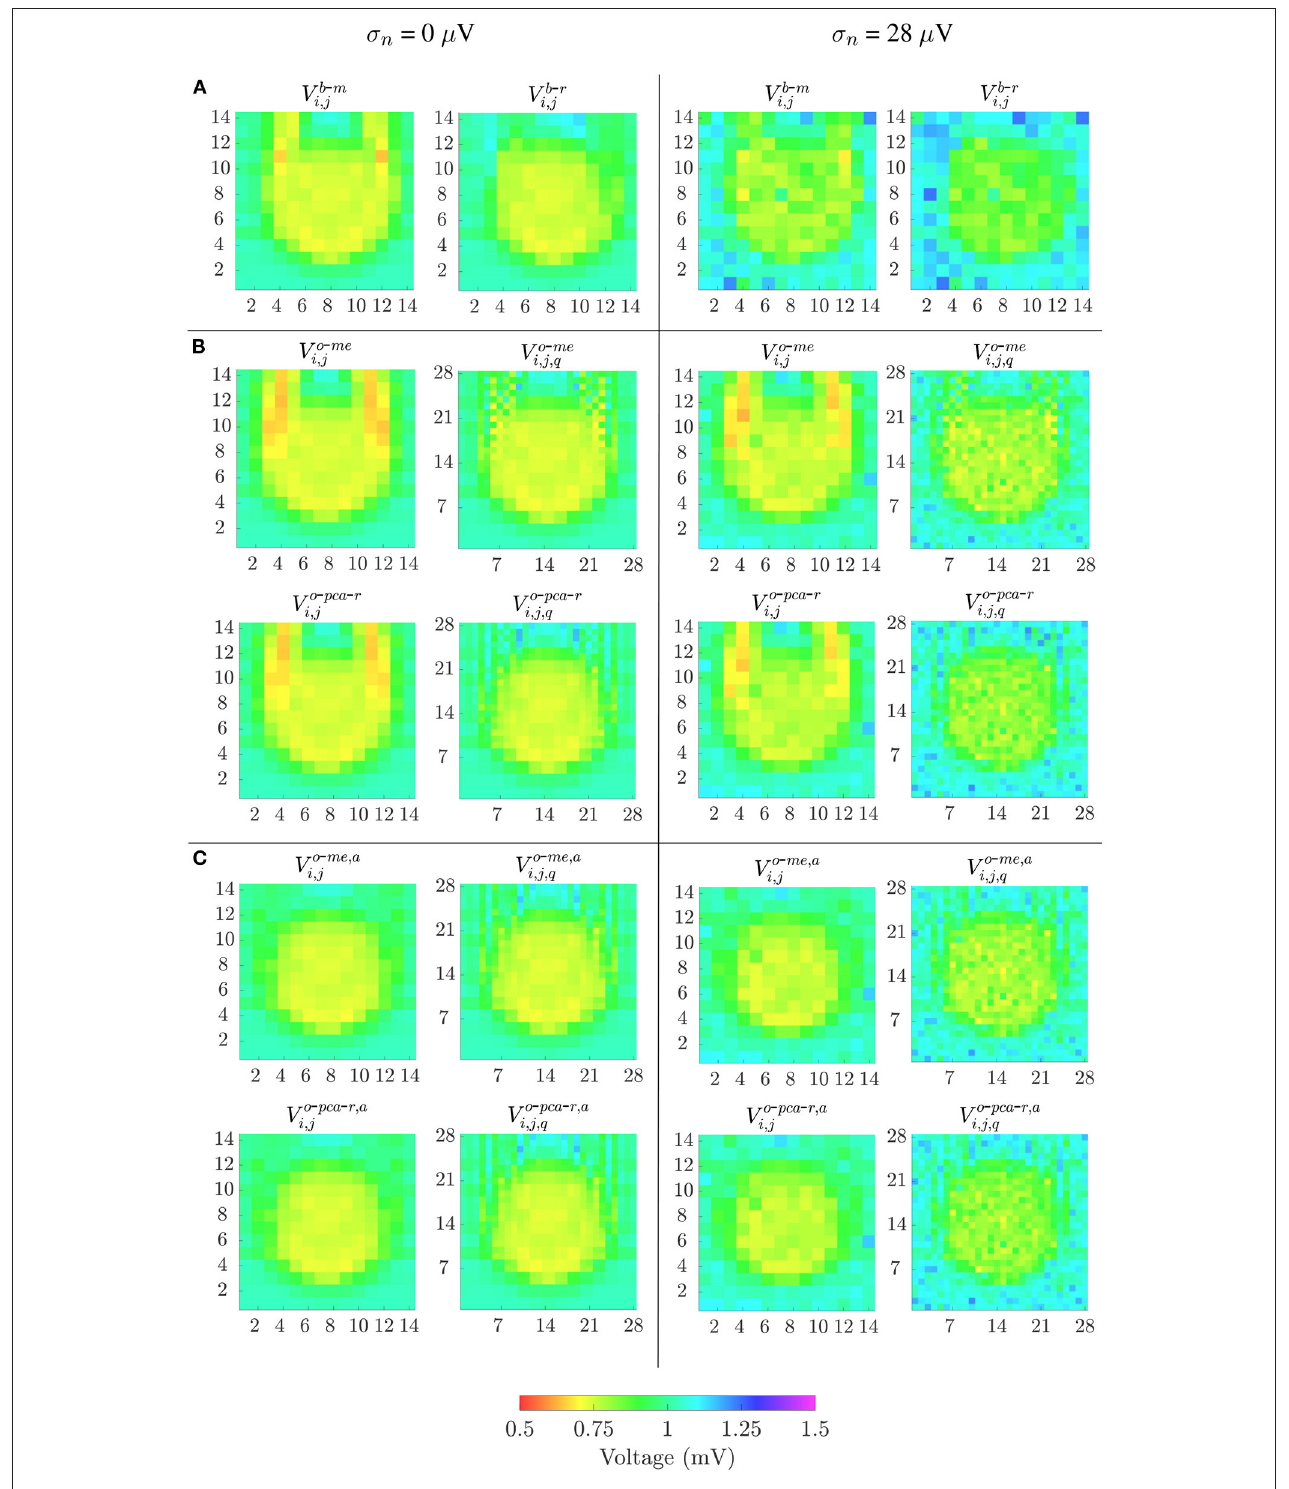
FIGURE 7 | Voltage maps when propagation direction is in the main direction of MEA ( 9 = 0 ◦ ). Left columns: noise-free bipolar maps (row A ) and omnipolar maps without (rows in B ) and with alignment (rows in C ) of b-EGMs; right columns: same types of maps performed in left columns, but from noisy b-EGMs (noise level with standard deviation σ = 28 µ V